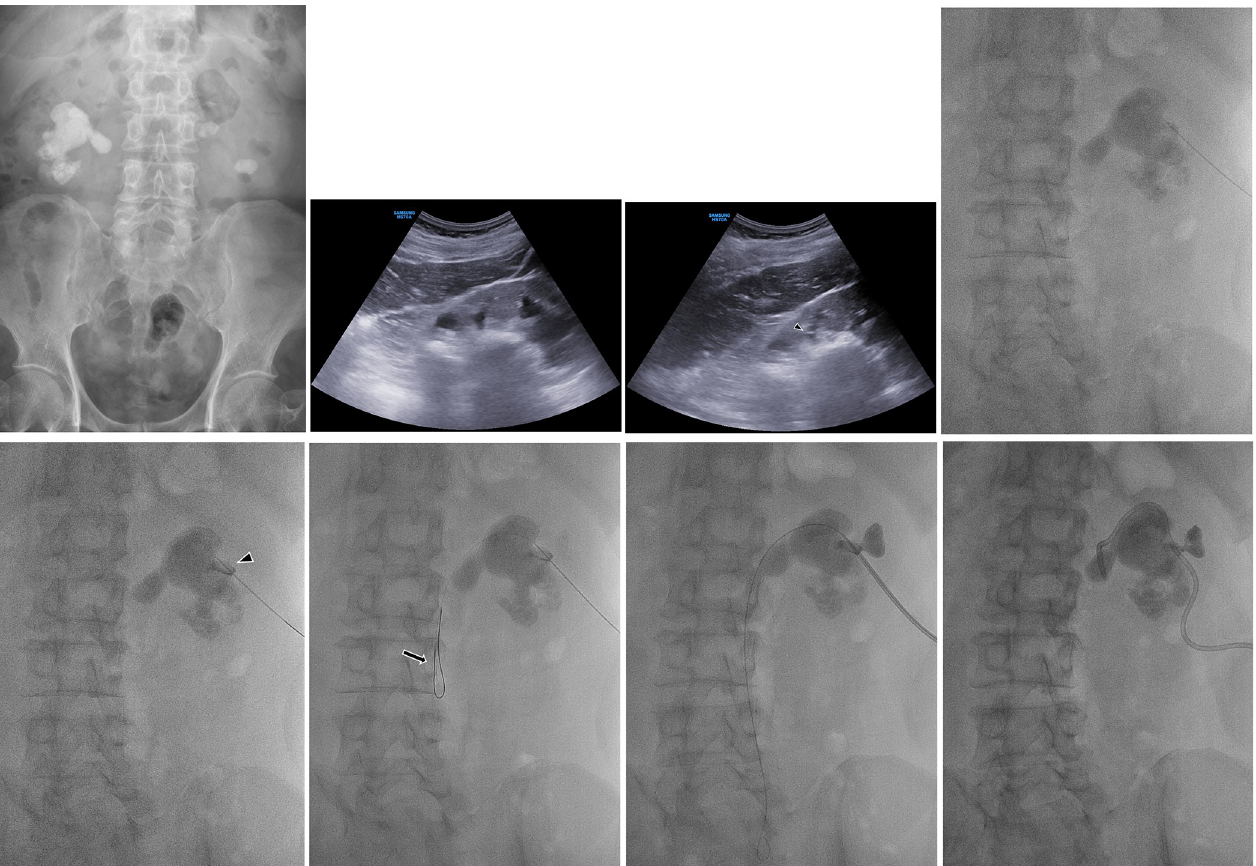
Fig 2. A representative case of a 61-year-old man with a right, partial staghorn stone. (A) A kidney, ureter, and bladder imaging exam identified a right, partial staghorn stone. (B) A grayscale ultrasonography image showed a staghorn stone in the right kidney with marked posterior acoustic shadowing. (C) A 21-G Chiba needle (arrowhead) was introduced into the periphery of the complex stone through the center line of the renal pyramid. (D) A radiograph image showed that the 21-G Chiba needle was introduced behind the stone. (E) A few millilters of contrast medium was injected, then the renal calyx was opacified by contrast medium (arrowhead). (F) A 0.018-inch guide wire (arrow) was introduced with rotating movements to minimize resistance at the tip as the wire advanced. (G) A 0.035-inch hydrophilic guidewire was introduced, and track dilatation was performed under fluoroscopic guidance. (H) An 8.5-Fr pigtail catheter was placed after sequential tract